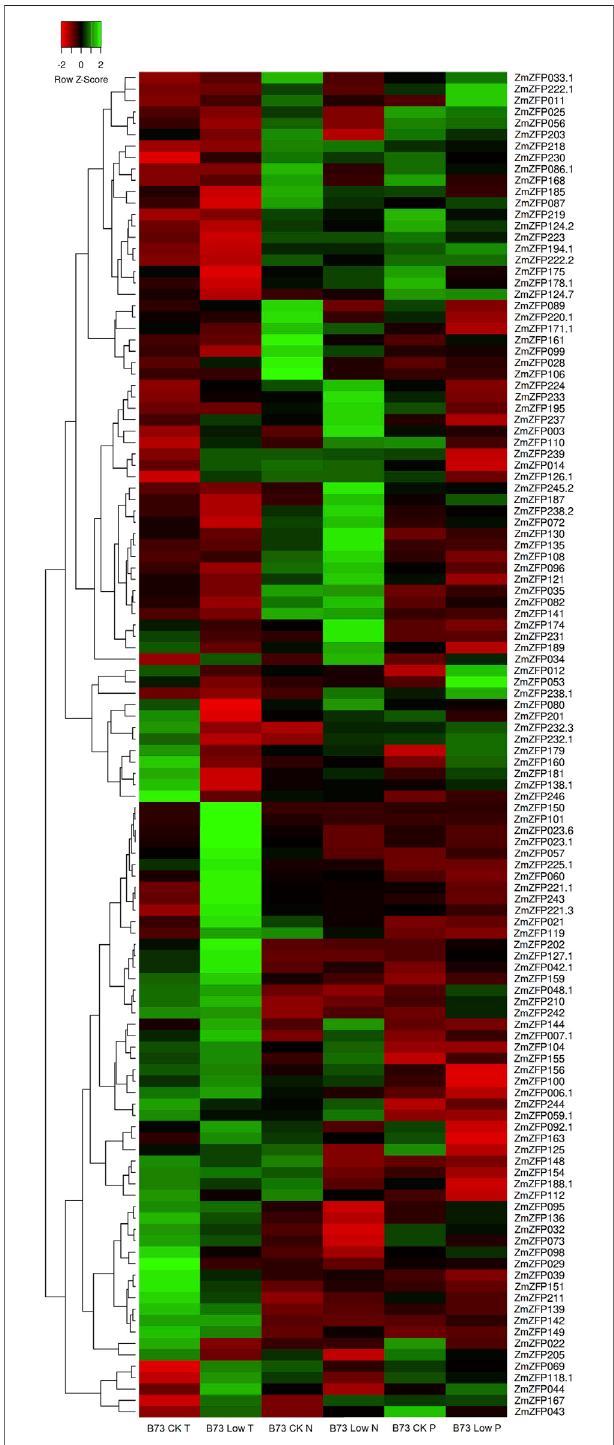
FIGURE 2 | Expression pro fi les of maize C2H2-ZF genes under low temperature, low nitrogen, and low phosphorus. The green, red, and black represent positive, negative, and neutral gene expression levels, respectively. Heat map hierarchical clustering of log 2 -transformed genes under low temperature, low nitrogen, and low